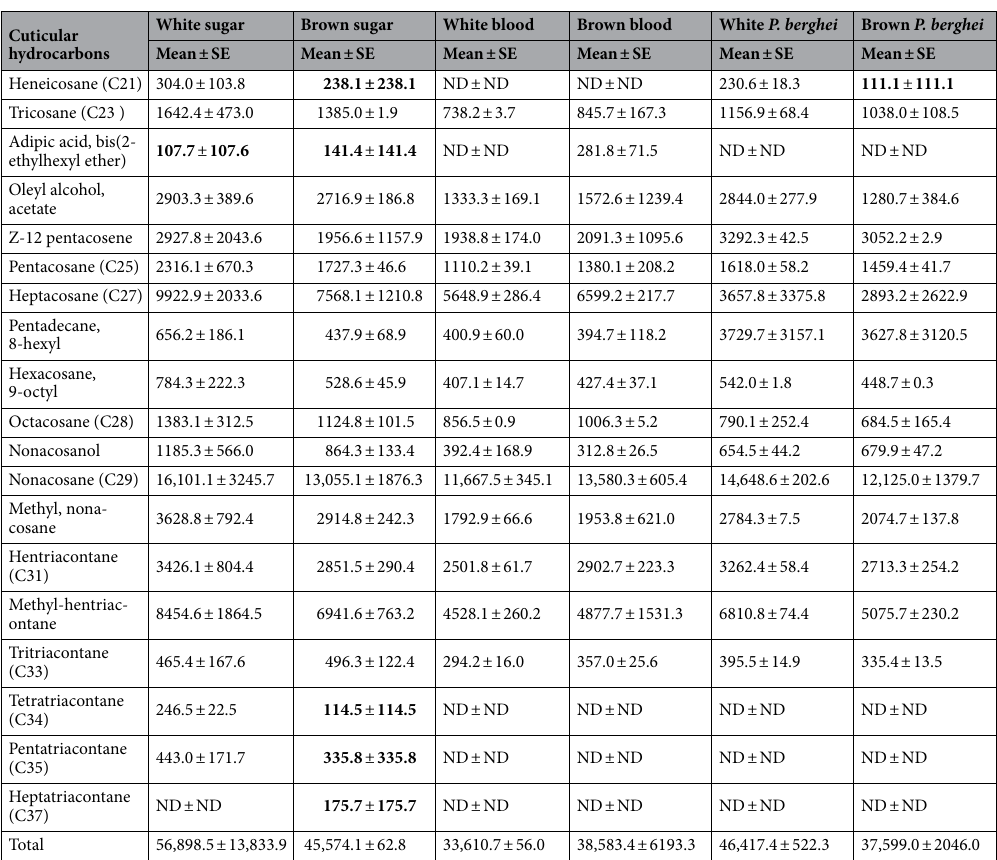
Table 1. Cuticular hydrocarbons and their abundance found in the White and Brown phenotypes fed with sugar, blood, or ookinete-containing blood (GC-FID peak area per mosquito equivalent). Mean values of two experiments performed in triplicates. SE standard error, ND not detected. Bold—CHC detected only in one